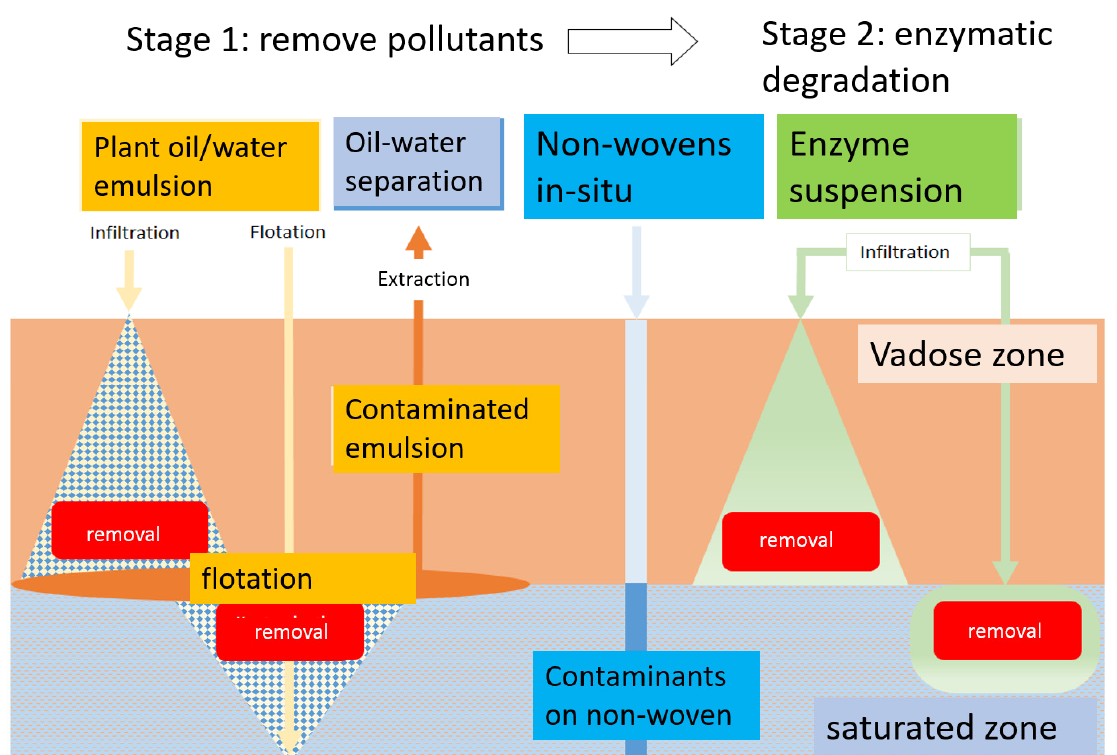
Figure 3. The project “Cleanup-Cascade” has two steps. See text for details.